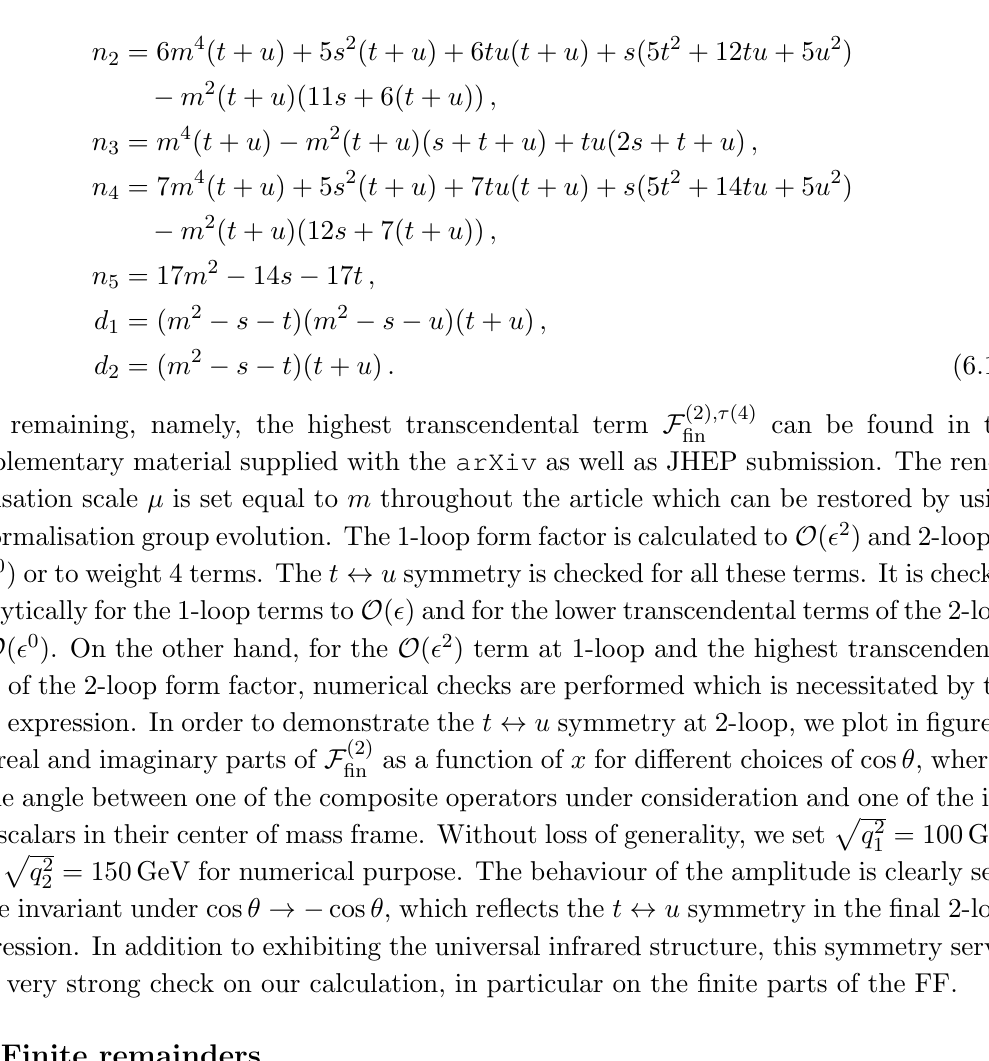
Figure 2 . Behaviour of the real and imaginary parts of values of cos (cid:18)